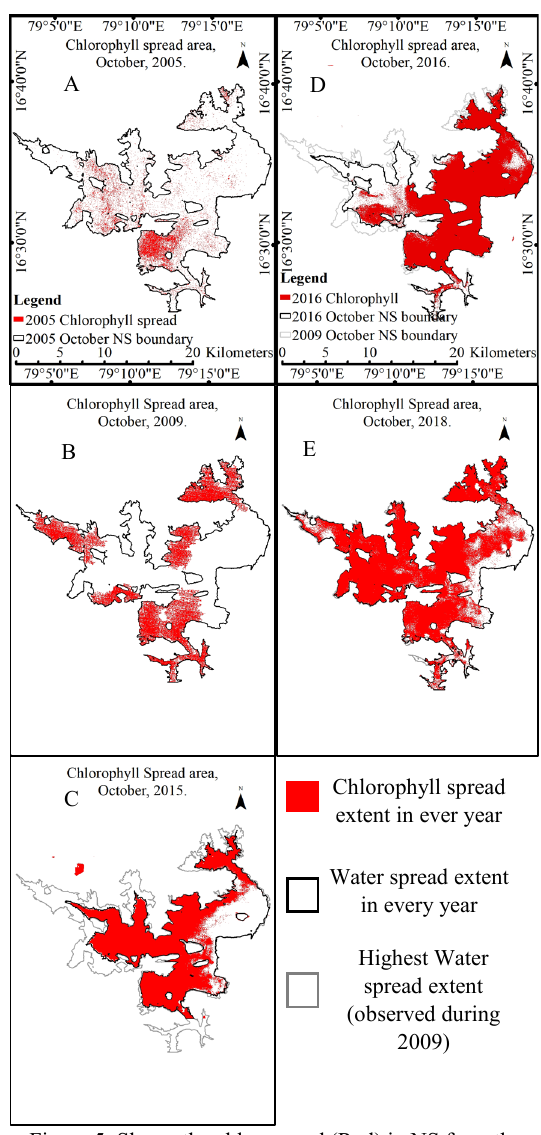
Figure 5: Shows the chl-a spread (Red) in NS from the October month of the year 2005, 2009, 2015, 2016 and 2018 from A – E